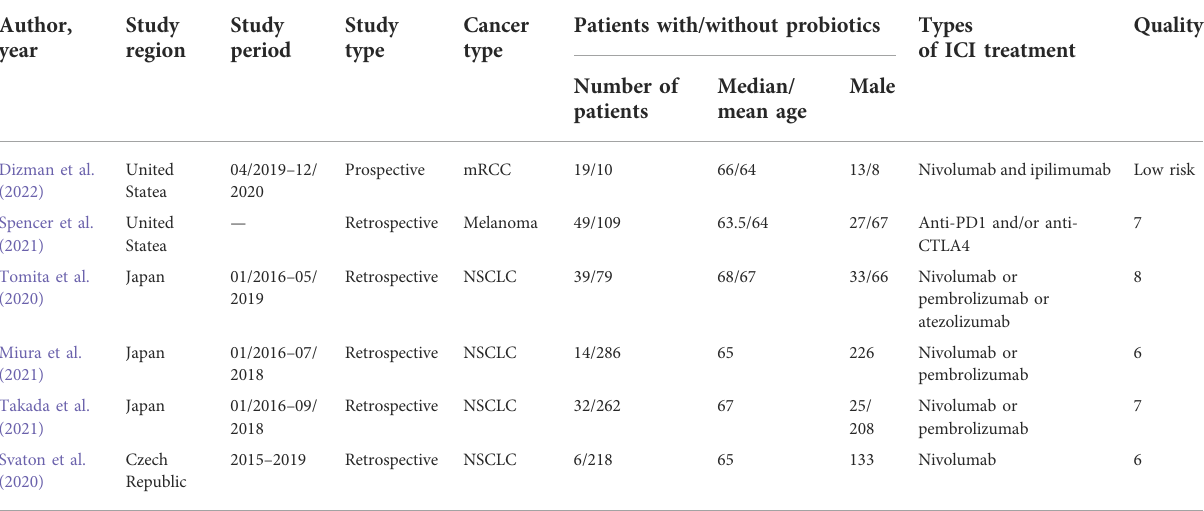
TABLE 1 Baseline characteristics of included